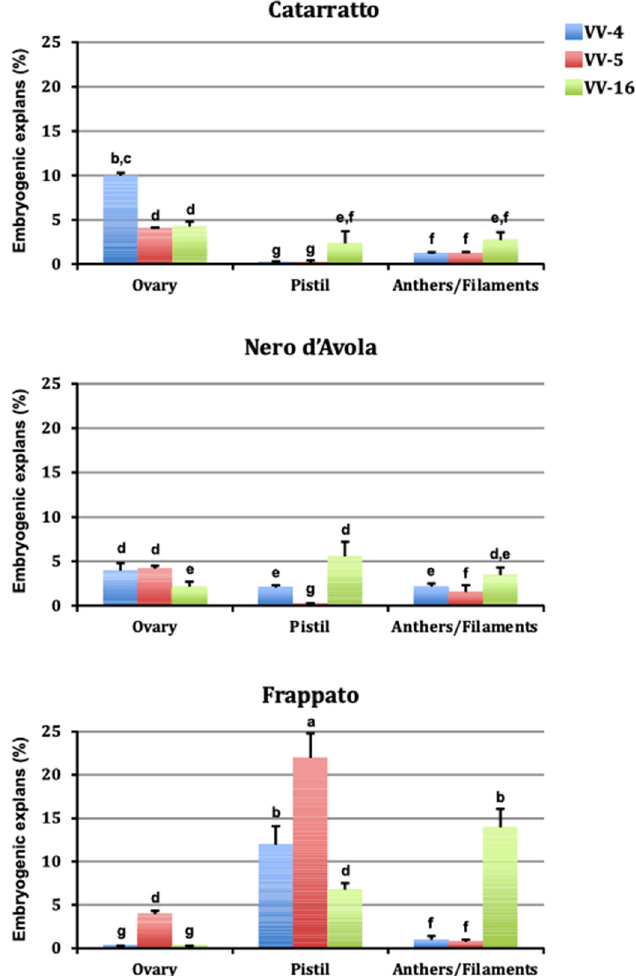
Figure 1. Percentages of embryogenic explants of ‘Catarratto’, ‘Nero d’Avola’, and ‘Frappato’ using three explant types and three PGR combinations. Data were collected 6 months after culture initiation and each treatment comprised 250 explants for anthers/filaments and 50 explants for ovaries and pistils. Means ± SE, values followed by the same letter are not significantly different at p < 0.05 level (Tukey’s test).